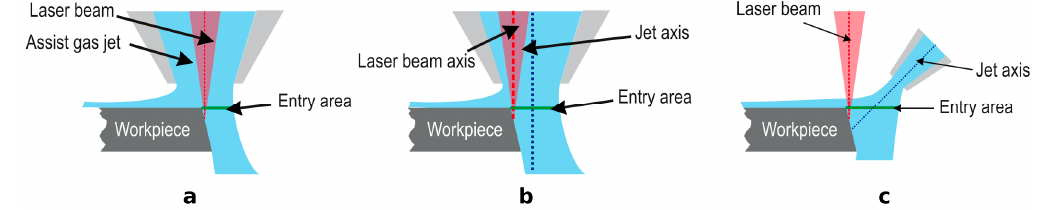
Figure 17. Schematic view of the ( a ) on-axis cutting process, ( b ) off-axis cutting process with the assist gas jet impinging normally to the workpiece, and ( c ) when the assist gas jet forms an angle with the laser beam.